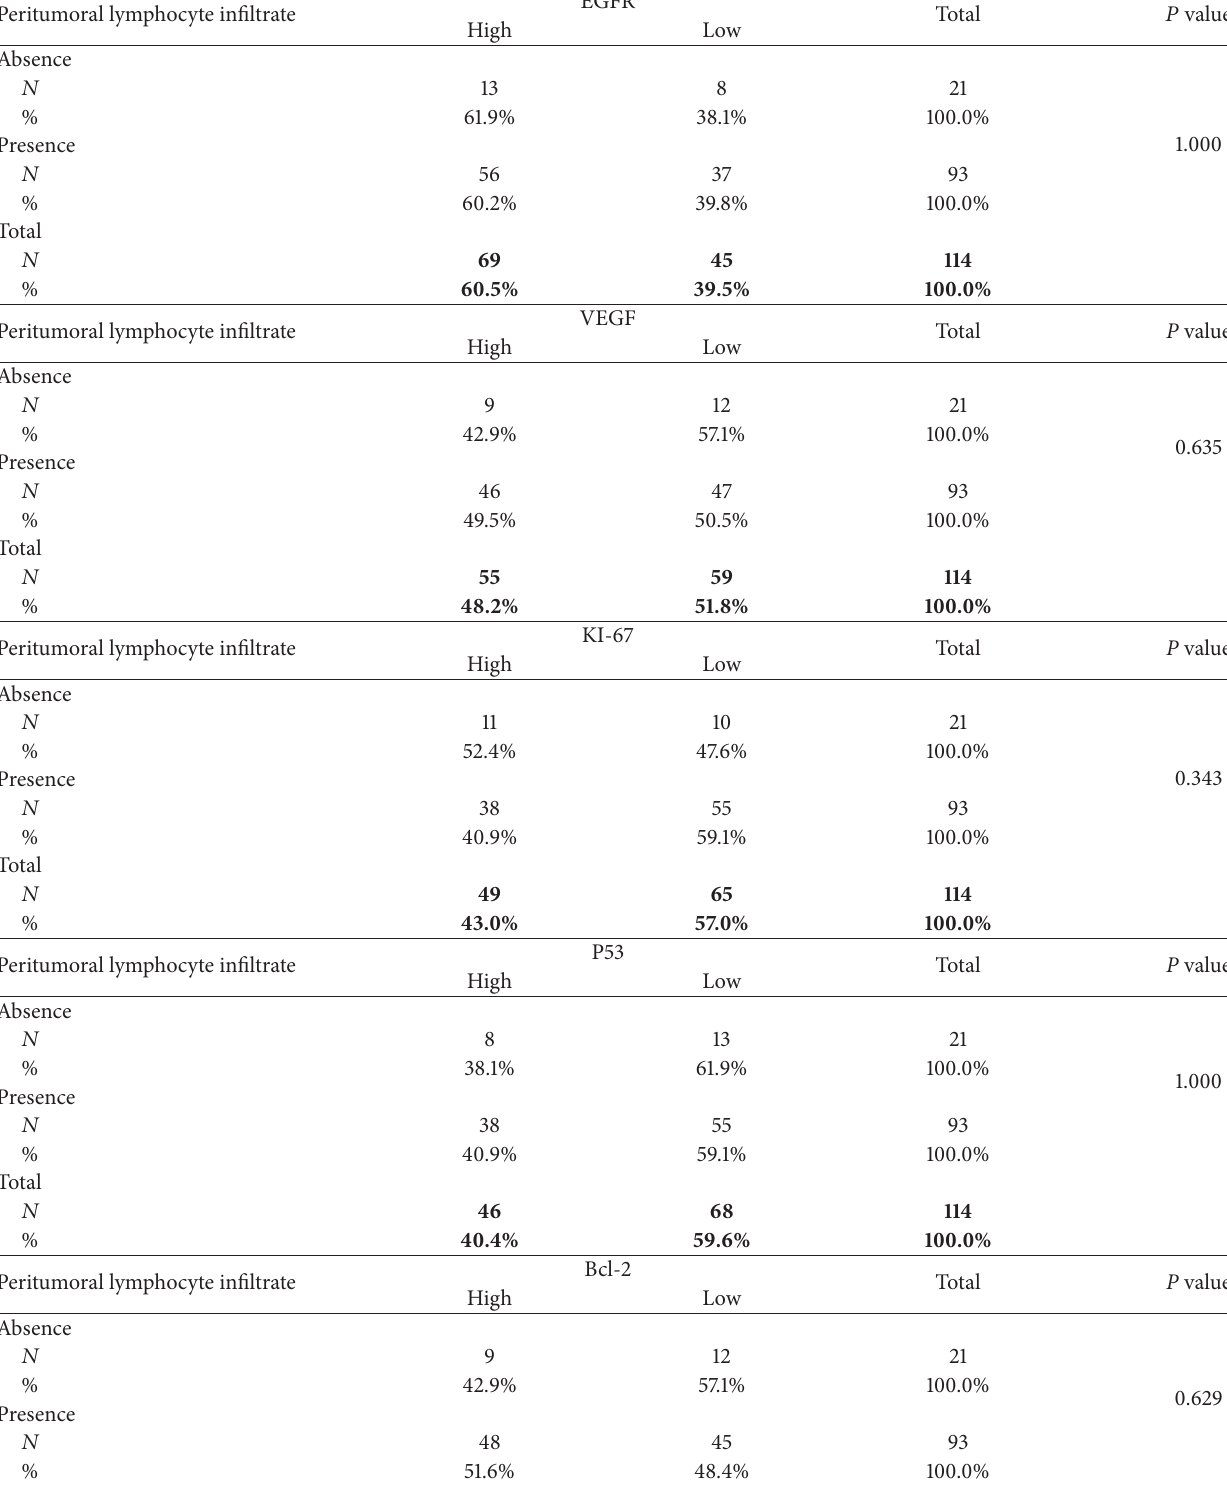
Table 5: The distribution of expression levels per IHC of proteins corresponding to ITGB-5, ITGA-3, MMP-2, MMP-9, and FN-1 ECM genes and EGFR, VEGF, KI-67, P53, and Bcl-2 molecules as per the peritumoral lymphocyte infiltrate in CRC ( 𝑛 = 114 ). Peritumoral lymphocyte infiltrate